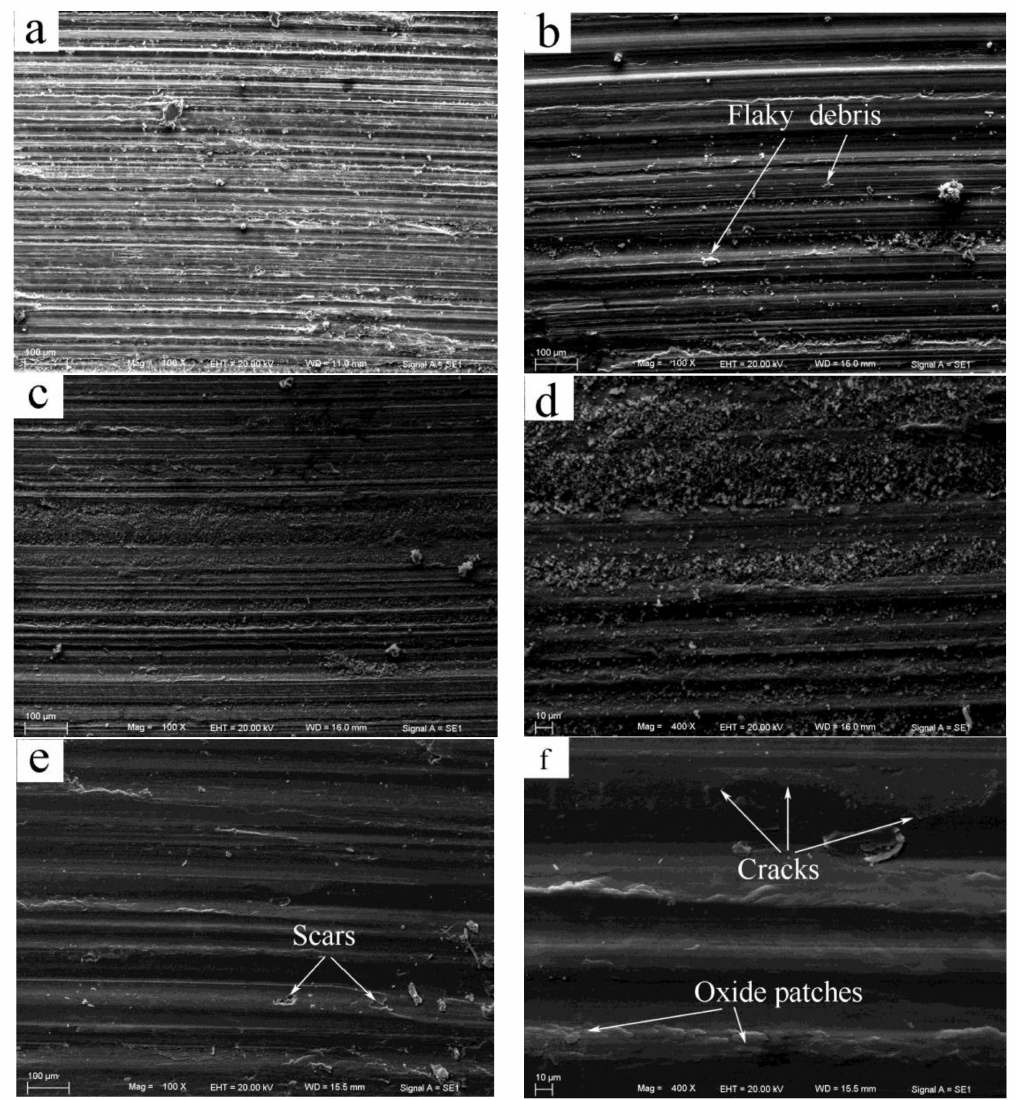
Figure 4. SEM (scanning electron microscope) morphologies of worn surfaces of Mg97Zn1Y2 alloy at 0.2 m/s and different applied loads: ( a ) 20 N, ( b ) 100 N, ( c ) 180 N, ( d ) 180 N, ( e ) 260 N, ( f ) 260